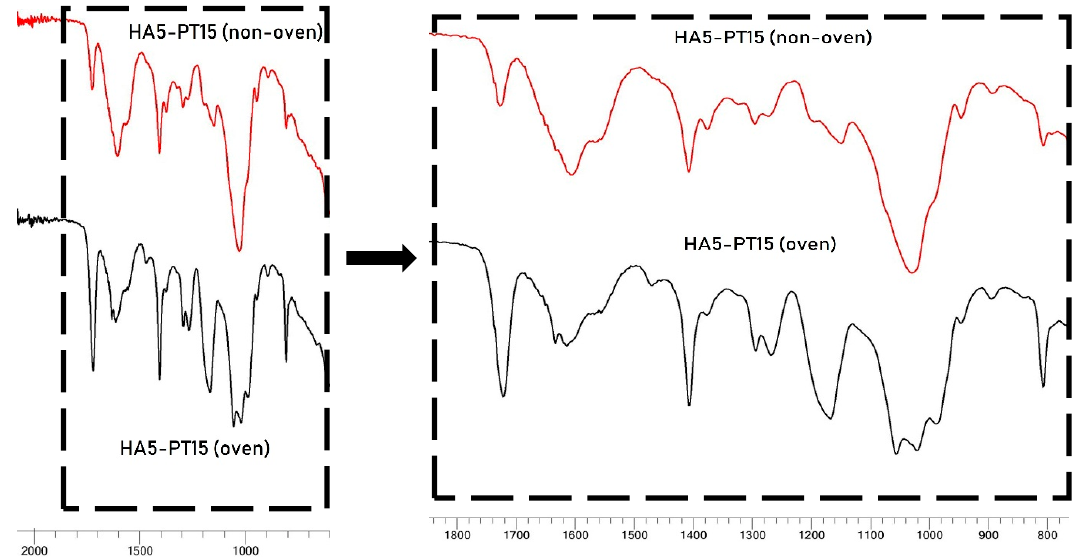
Figure 15. HA5-PT20 before and after crosslinking by the oven-assisted thermal method (x-axis is the wavenumber/cm − 1 ).